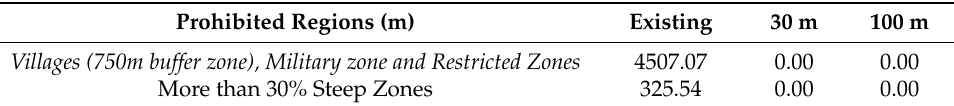
Table 5. Prohibited regions